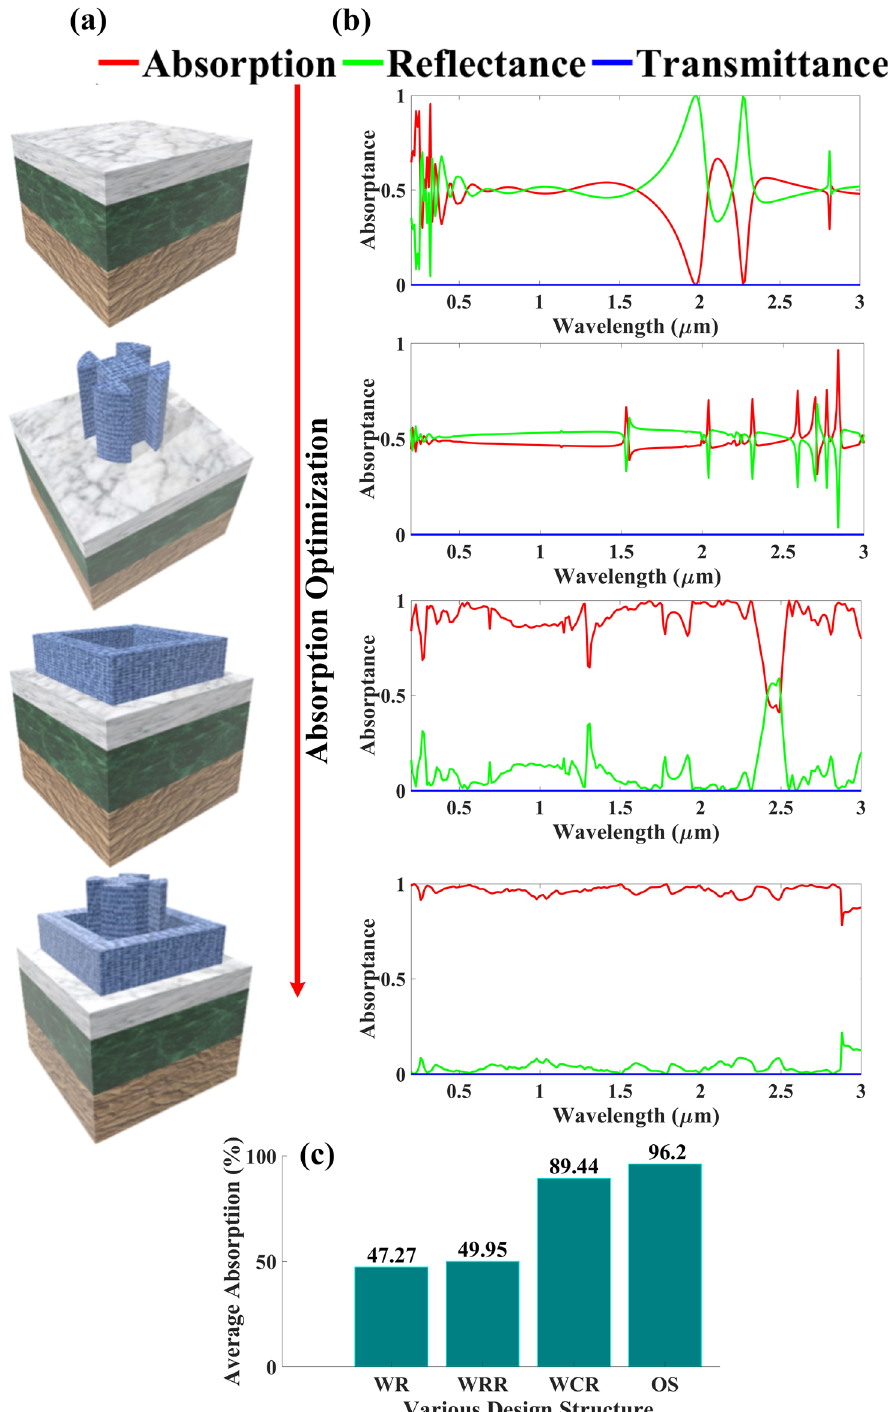
Figure 2. Representation of the step-by-step attainment of the optimized UWBSEA structure, ( a ) multiple variations of SEA structures until the UWB absorption is achieved and the ( b ) corresponding absorption plot, ( c ) bar plot depicting the effect of inserting new structures on the overall average